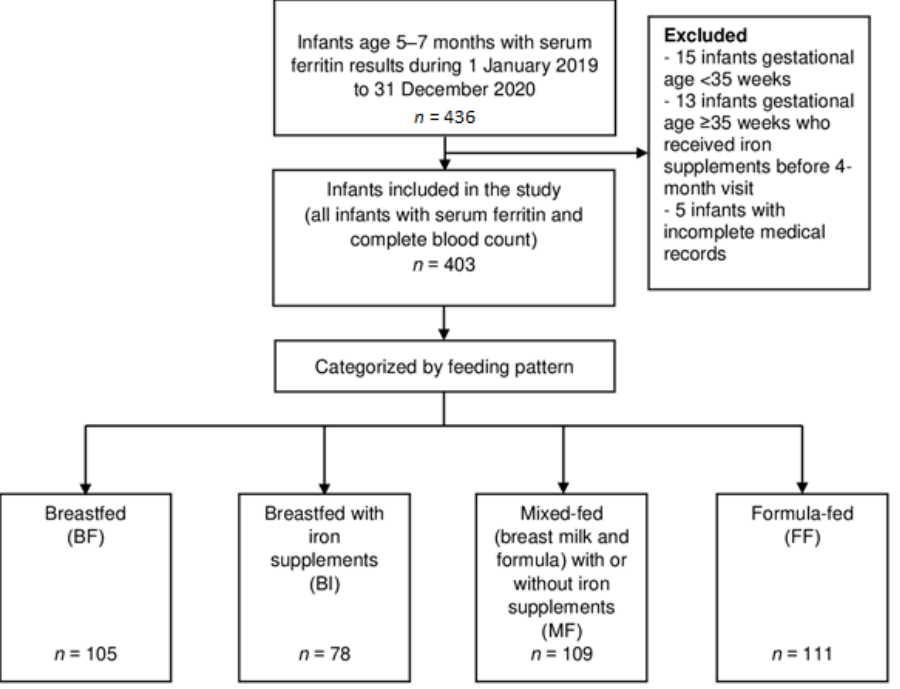
Figure 1. Flow chart of infants in the study. There were no significant differences in the infants’ baseline characteristics between the four groups, other than infants categorized as large for gestational age. Complementary feeding was introduced before 6 months of age in 31.1% of BF, 53.1% of BI, 79.8% of MF, and 85.7% of FF infants. All infants (100%) in the BI group and 40 (36.7%) in the MF group received iron supplements, started at the 4-month visit, whereas no infants in the BF and FF groups received iron supplements (Table